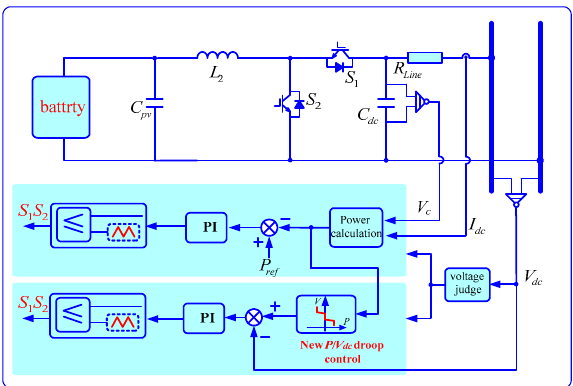
Figure 6. The overall scheme of the ES unit on the direct current (DC) ‐ side.